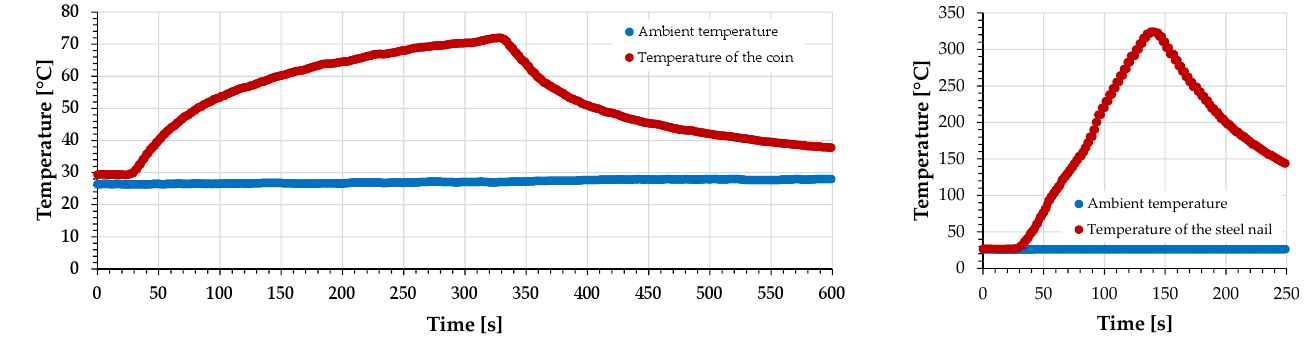
Figure 15. Heating of test objects as a function of time at a current of 50Arms in the ground assembly coil ( left ) Test object 2 ( right ) Test object